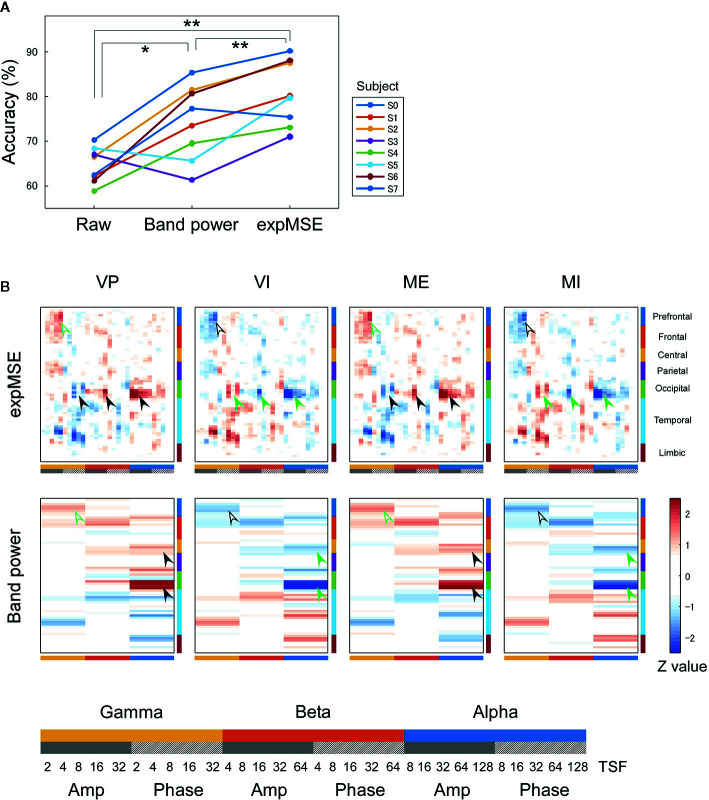
Intra-subject decoding of imagery behavior. (A) Decoding accuracies compared among raw data, band power and expMSE. Each color corresponds to a subject. *p < 0.05 and **p < 0.01. (B) Task-related sensitivity maps of example (subject S0). Upper and lower panels respectively show maps for the expMSE and band power (VP, visual perception; VI, visual imagery; ME, motor execution; MI, motor imagery; black filled arrow, modality-specific sensitivity; green filled arrow, inverted sensitivity in the modality-specific regions; black open arrow, modality-independent sensitivity; green open arrow, inverted sensitivity in the modality-independent regions). At the bottom are details of the horizontal axes: frequency × component (Amp/Phase) × TSF; Amp, amplitude expMSE; Phase, phase expMSE.